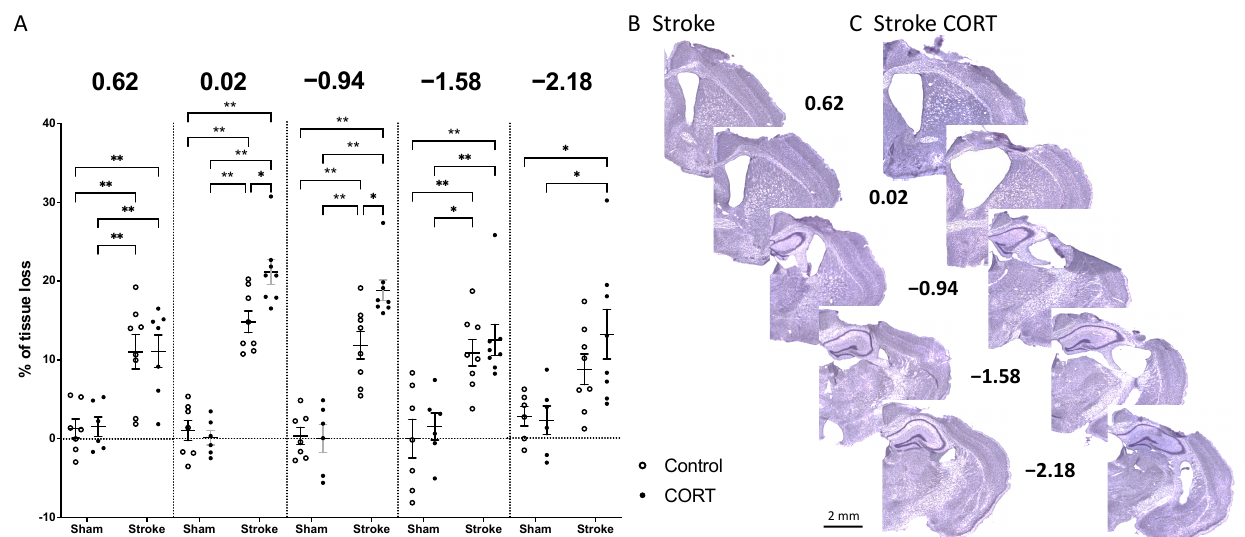
Figure 1. Corticosterone (CORT) increases tissue loss after stroke: ( A ) Percentage of tissue loss at five different Bregma levels across the four groups: sham, sham + CORT, stroke, stroke + CORT. The representative images show Cresyl violet staining of the same five Bregma levels in ( B ) representative stroke brain at 17 days post-stroke or ( C ) representative stroke + CORT brain at 17 days post-stroke with 14 days of CORT treatment. Data on the graph are expressed as mean ± SEM ** p < 0.01, * p <